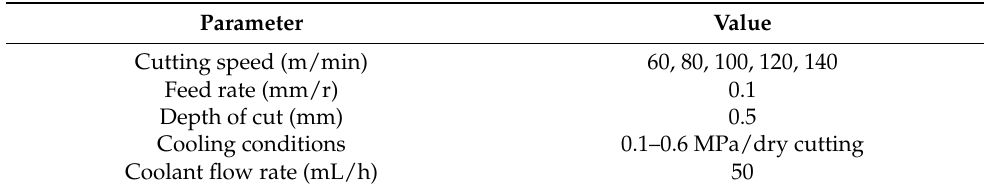
Table 4. The parameters of cutting